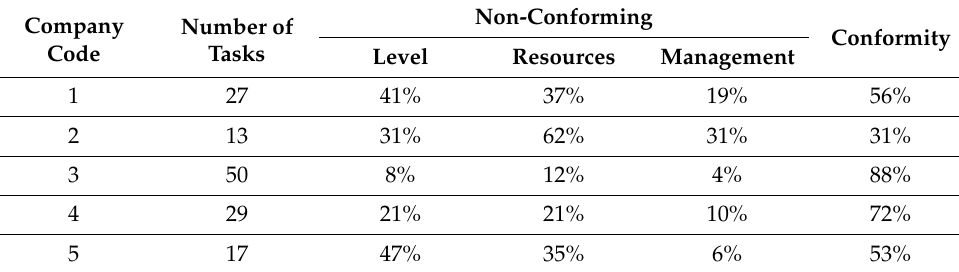
Table 7. Consistency of tasks conformity evaluation at